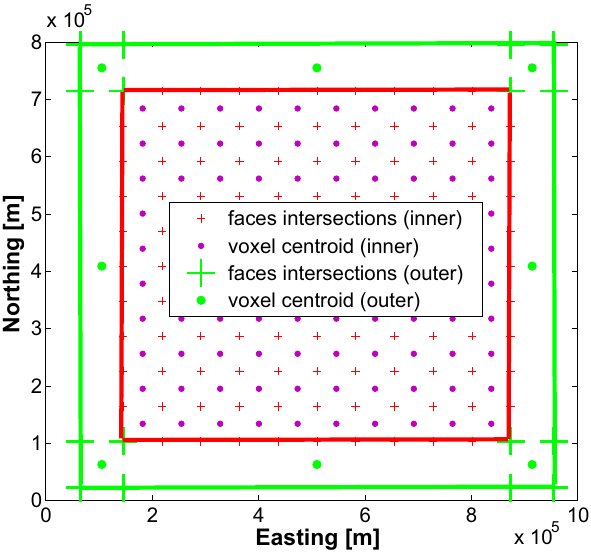
Fig. 11. The setup of tomography nested models, green line rep- resents outline outer model, while red line shows limits of inner model.